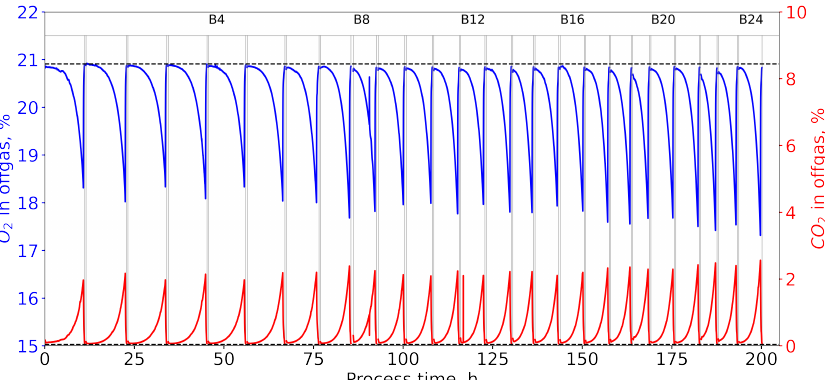
Figure 3. The concentrations of O 2 and CO 2 in the off-gas of an automated ALE experiment (GM2) in an L scale stirred-tank bioreactor are shown over the course of 25 consecutive batch experiments totaling a process duration of 200 h. A culture of E. coli K12 MG1655 was grown with RB medium at 37 ◦ C, 600–1400 rpm, 40 vvm, and an initial glycerol concentration of 12 g L − 1 as sole carbon source. The ALE process was performed in an automated system in a repeated batch mode with a bioreactor volume of 575 mL. Vertical lines indicate the start and end of the medium exchange procedure between batches (grey). The concentrations of O 2 = 20.91% and CO 2 = 0.04% in the pressurized air in the inflow are depicted by the horizontal, dashed lines (black). Batch numbers are indicated with B4–B24. The shown data were used as input for the black box model to calculate OUR and CER, as well as derived state variables, such as the estimated biomass and substrate concentrations and the specific growth rate according to Equation (7)–(10).